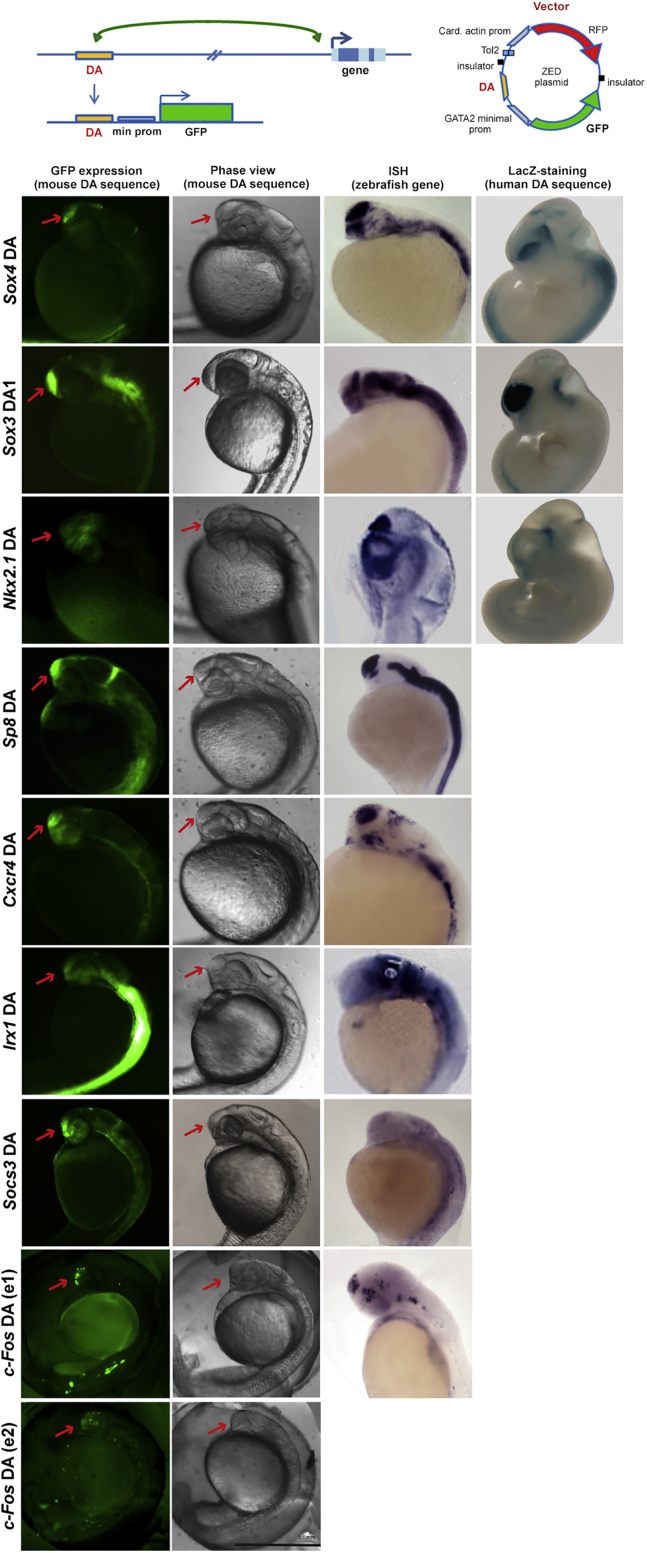
Distal Anchors in Sox2-Dependent Interactions Drive GFP Transgene Activity to Zebrafish BrainTop: enhancer-dependent GFP-reporter (ZED): distal anchors (DA) from Sox2-dependent interactions are cloned upstream to a minimal promoter and GFP. Bottom: first and second left columns, GFP expression in transgenic embryos and bright-field images (F1 of stable lines, except for c-fos, transient transgenics). Third column: expression (in situ hybridization from http://zfin.org) of the endogenous zebrafish gene corresponding to the gene connected, in mouse, to the tested anchor. Fourth column: forebrain lacZ staining driven by transgenes carrying the human enhancers corresponding to the anchor (from https://enhancer.lbl.gov) (Visel et al., 2009).See also Figure S6 and Table S6.